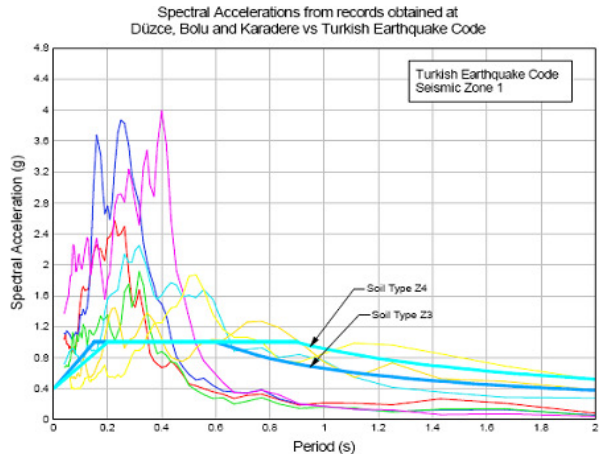
Figure 10: Structural analysis model of a viaduct pier a) general, b) top, c) base view Fig. 10. Structural analysis model of a viaduct pier (a) general, (b) top, (c) base view.